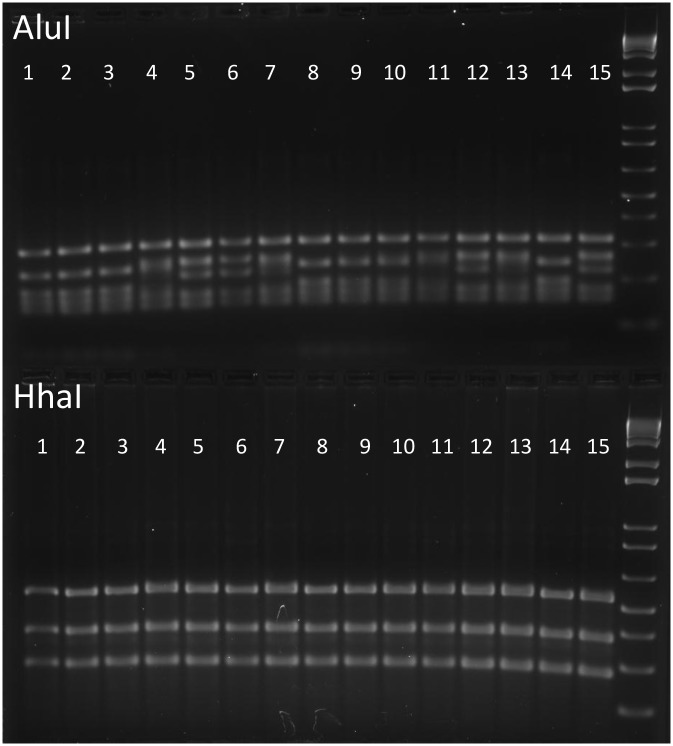
RFLP Patterns for EHS+ Lpd-/- Mice.Results from 15 animals are shown, with AluI digest on the top, and the corresponding HhaI digest shown on the bottom for each sample. While HhaI digests all exhibit the typical banding pattern for H. typhlonius, there is variability in the AluI patterns. Rows 1, 2, 3, 8, 9, 10, and 14 are all characteristic of H. typhlonius, whereas the remaining samples showed patterns that were less readily identifiable, suggesting coinfections. These animals were later determined to be co-infected with H. hepaticus by species-specific PCR.